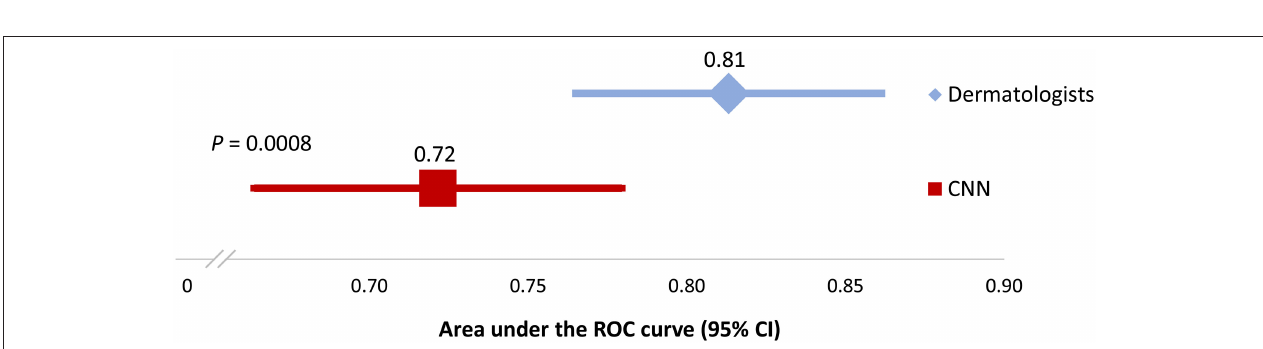
FIGURE 2 | ROC curves. Each point on the figure represents one dermatologist with respect to specificity and sensitivity in terms of correctly classifying a melanoma as invasive. CNN, convolutional neural network; ROC, receiver operating characteristics.